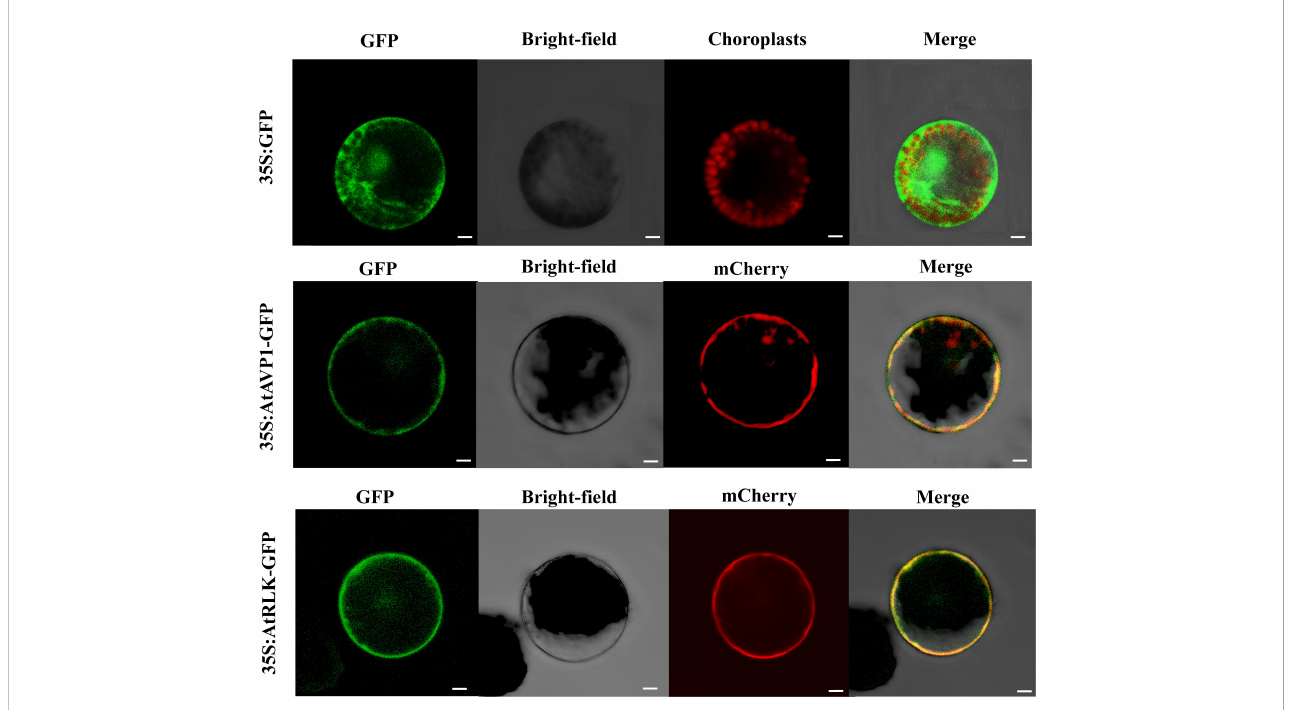
FIGURE 4 Subcellular AtAVP1 and AtRLK localization in Arabidopsis protoplasts The 35S:AtAVP1-GFP, 35S:AtRLK-GFP, and 35S:GFP control vectors were transiently expressed in Arabidopsis protoplasts. Compared to that of the 35S:GFP construct, the expression of 35S:AtAVP1-GFP and 35S:AtRLK-GFP was localized to the plasma membrane of the protoplasts. Fluorescence was observed using a Zeiss LSM980 confocal laser scanning microscope 16 h after transformation. Membrane marker protein (mCherry) was co-expressed with 35S:AtAVP1-GFP. Scale bars = 5 m